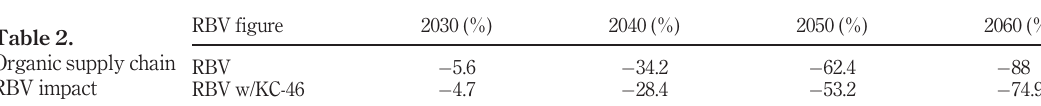
Table 1. Independent RBV factors impact